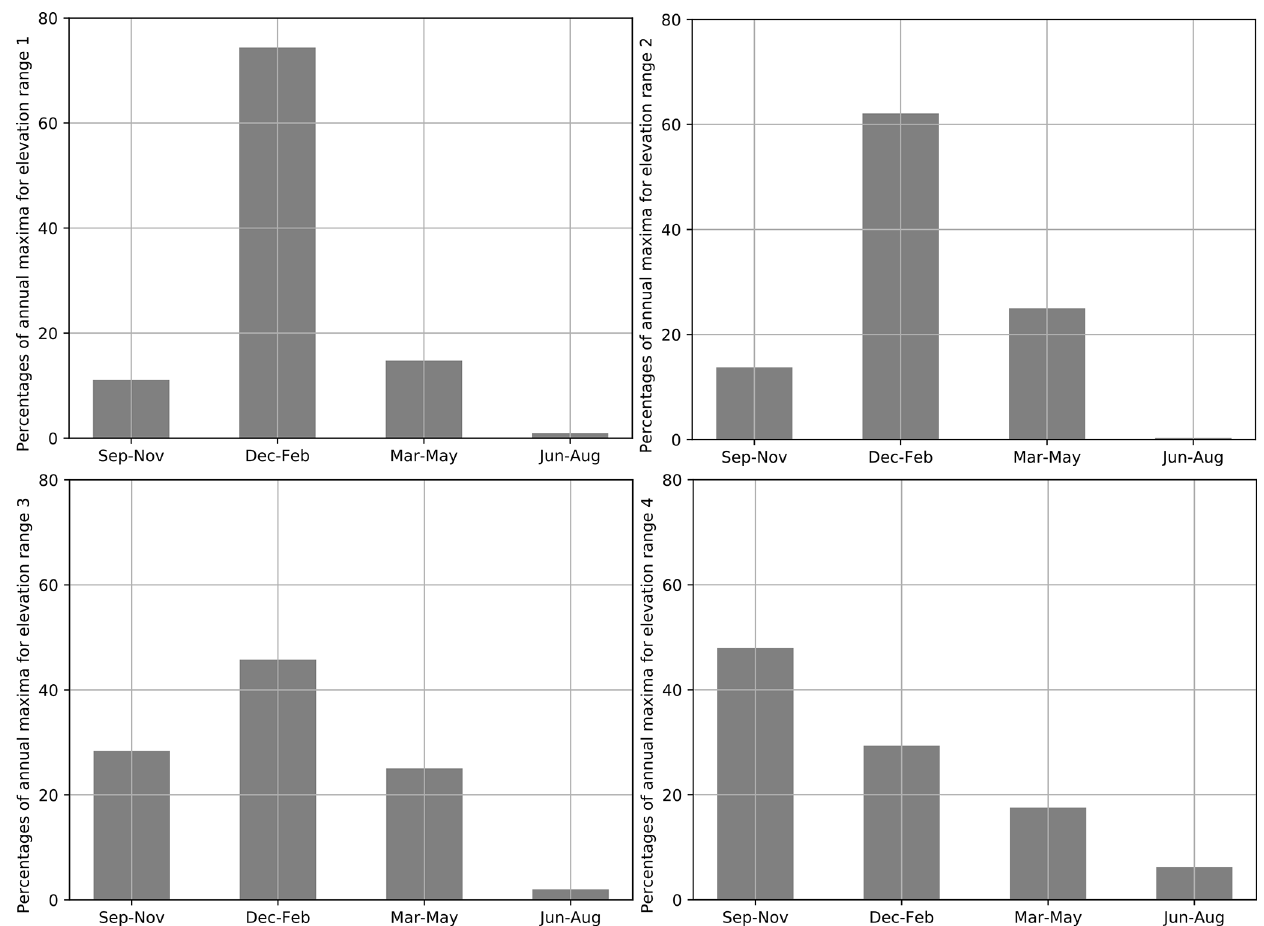
Figure E1. Seasons when the annual maxima of daily snowfall occurred for elevation range 1 (below 1000m), elevation range 2 (between 1000 and 2000m), elevation range 3 (between 2000 and 3000m), and elevation range 4 (above